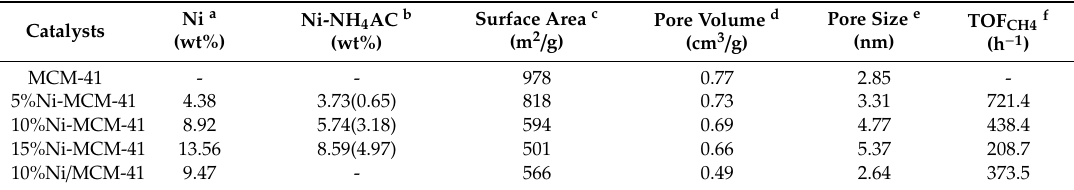
Table 1. Physicochemical properties of reduced catalysts.